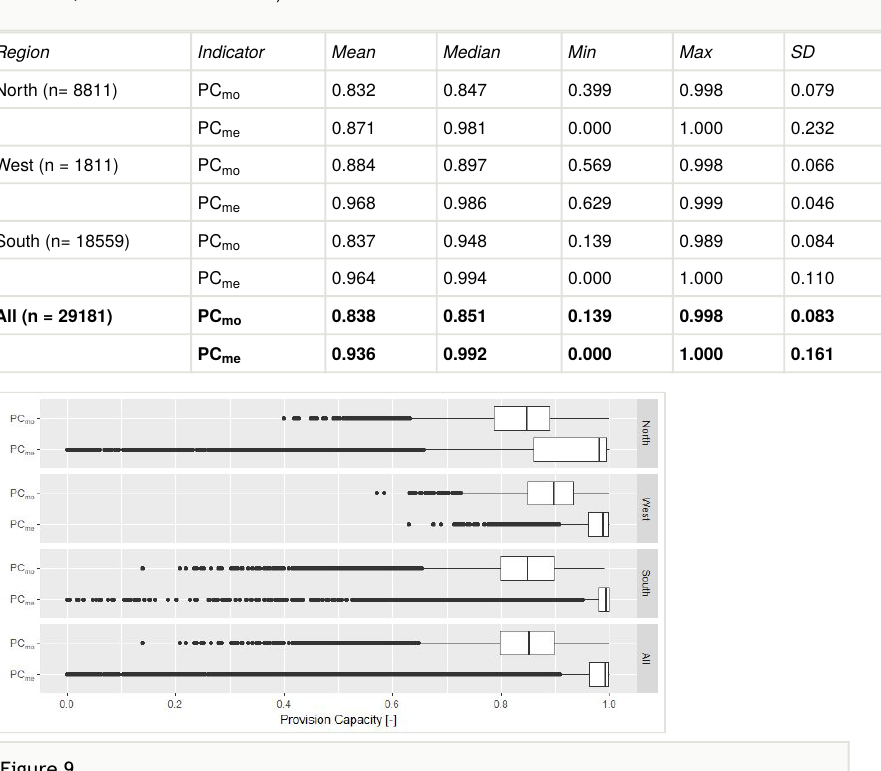
Statistical values for the indicators describing the provision capacity (PC : based on modelled actual soil loss data, PC : based measured actual soil loss data), grouped by regions [t ha a ] (n = 29181, number of raster cells).